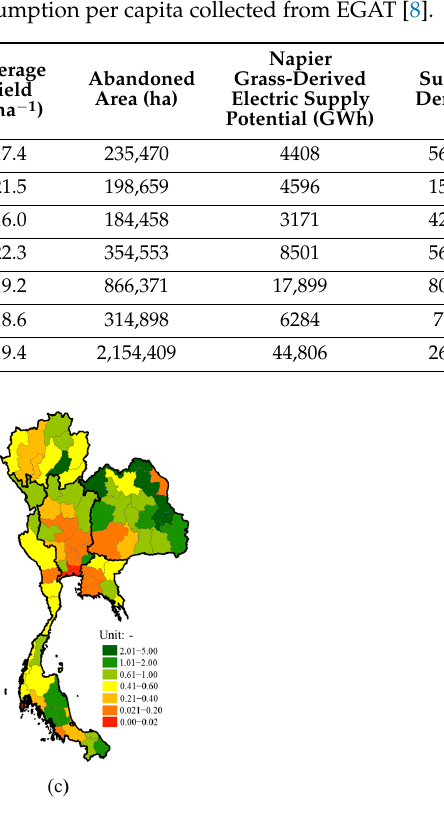
Figure 6. Provincial distribution of: ( a ) Napier grass-derived electric supply potential; ( b ) total electric consumption per capita; and ( c ) the supply–demand ratio.